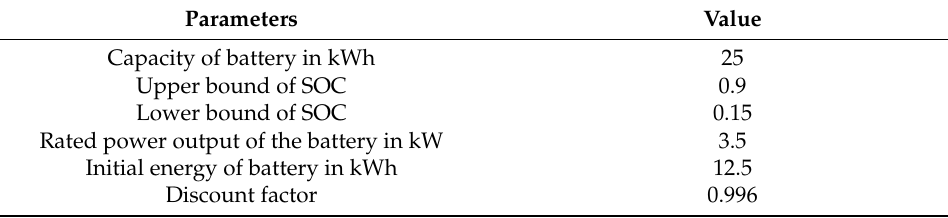
Table 1. Parameters for experiment.